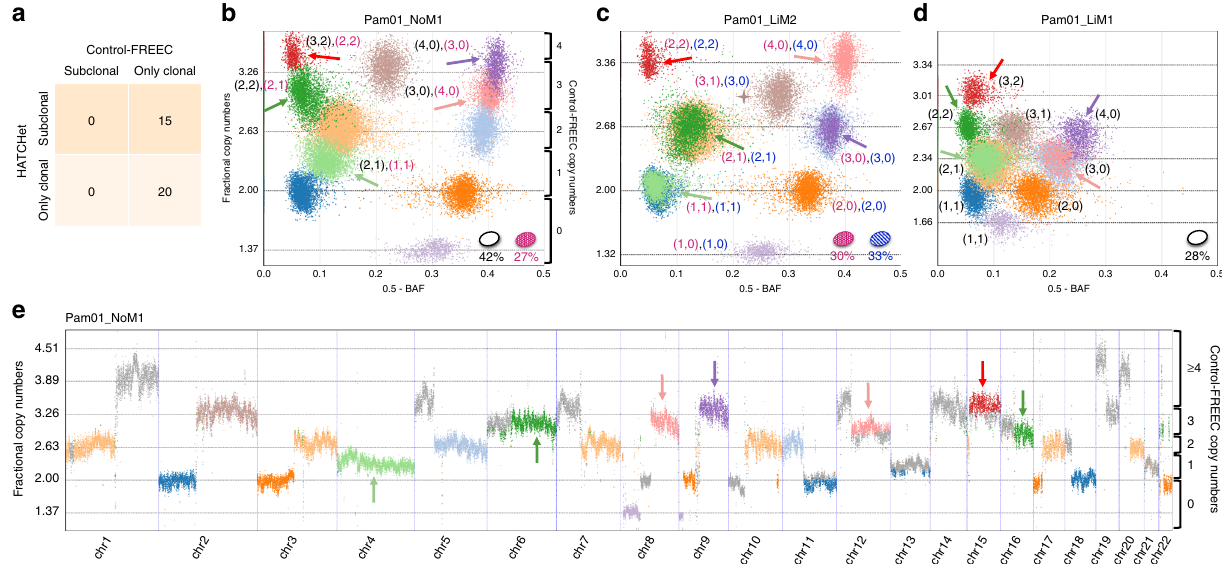
Fig. 4 HATCHet identi fi es well-supported subclonal CNAs in metastatic pancreas cancer patients. a HATCHet identi fi es subclonal CNAs in 15 of 35 samples, while published analysis used Control-FREEC and excluded subclonal CNAs. b In the lymph node metastasis sample Pam01_NoM1, HATCHet infers two distinct tumor clones (ellipses in lower right of plot with corresponding proportions) and a tumor purity of 69%. Five sample-subclonal clusters (arrows) of 50kb genomic bins occupy intermediate positions between the other sample-clonal clusters (dashed black lines) in the scaled BAF-RDR plot, and thus have distinct copy-number states in the two clones, corresponding to subclonal CNAs. Control-FREEC copy numbers are shown on the right y-axis labels. c In a second liver metastasis sample Pam01_LiM2 from the same patient, HATCHet infers two distinct tumor clones, one (red) shared with the lymph node sample Pam01_NoM1. A large sample-subclonal cluster (brown, starred) occupies an intermediate position in the scaled BAF-RDR plot and has distinct copy-number states in the two clones. In contrast, the fi ve sample-subclonal clusters in Pam01_NoM1 (arrows) clearly overlap the sample-clonal clusters in this sample and thus correspond to clonal CNAs (dashed black lines). d In the liver metastasis sample Pam01_LiM1, HATCHet identi fi es a single tumor clone (white) that is shared with the lymph node metastasis sample Pam01_NoM1 in b . The fi ve sample-subclonal clusters in Pam01_NoM1 (arrows) correspond to clonal CNAs in sample Pam01_LiM1 but have different copy-number states than those in c . The inferred low tumor purity (28%) of this sample results in a partial overlap of clusters that are clearly distinguished in higher purity samples in b and c . e The fi ve sample-subclonal clusters in Pam01_NoM1 (arrows) correspond to large genomic regions with values of RDR that are clearly distinct from the other sample-clonal clusters (dashed black lines). Genomic regions that are part of small clusters or have out-of-scale values are reported in gray. Ranges of fractional copy numbers corresponding to the total copy numbers inferred by Control-FREEC in the previously published analysis are shown on the right y -axis